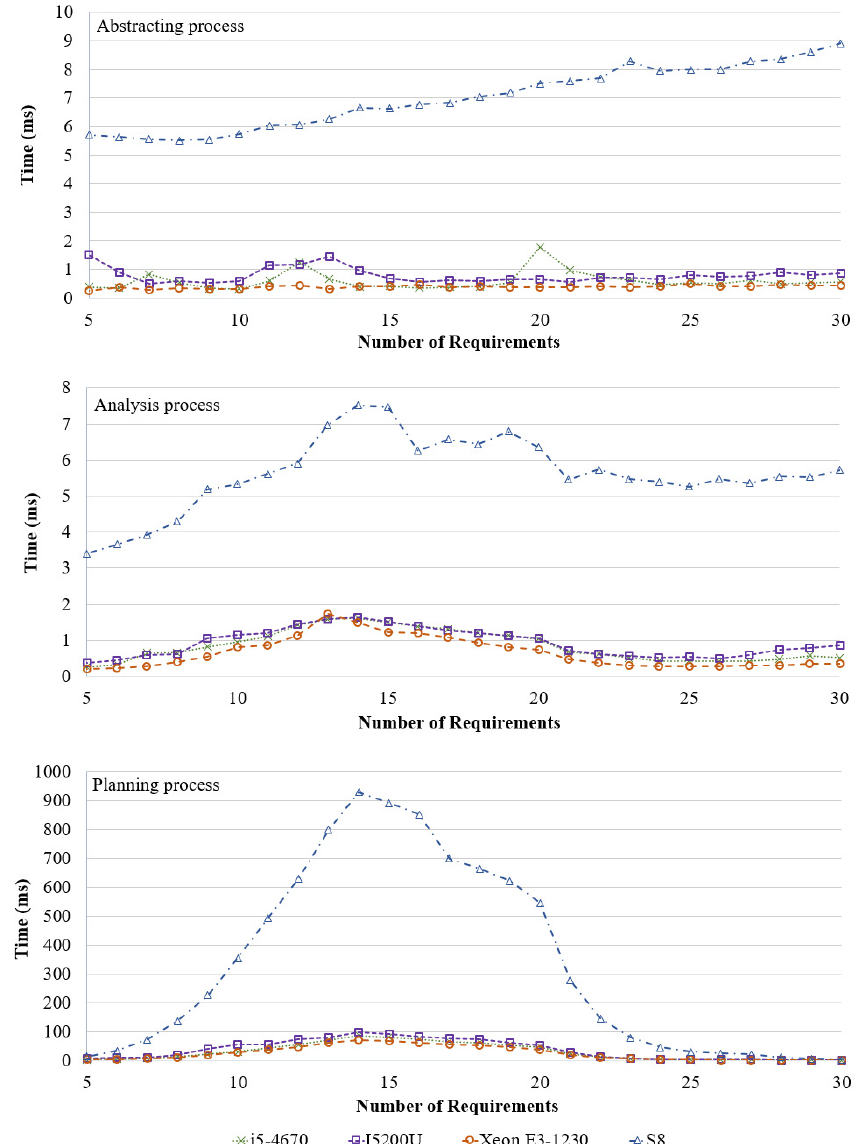
Figure 4. Results with fixed act-devices and increasing